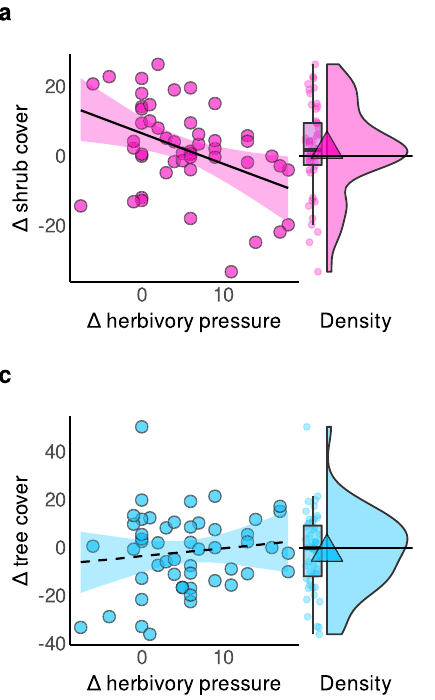
Dashed regression lines represent statistically unclear relationships. Frequency distributions (density,boxplot and points) of the respectiveresponse variables are displayed alongside. Boxplots bound the interquartile range (IQR) divided by the median and whiskers extend up to a maximum of 1.5 × IQR beyond the box. Tri- angles indicate the mean. Horizontal lines at zero indicate no change. Source data are provided as a Source Data fi le.